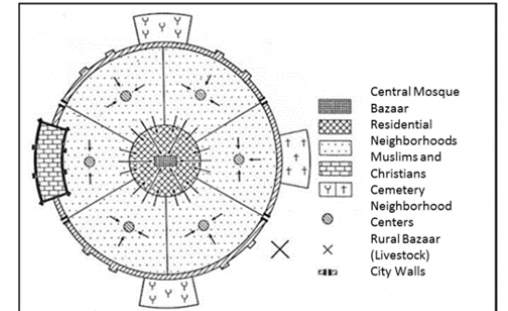
Figure 1 .Islamic City Model (Source: Dettmann 1969, Cited by Shafaqi 2008).